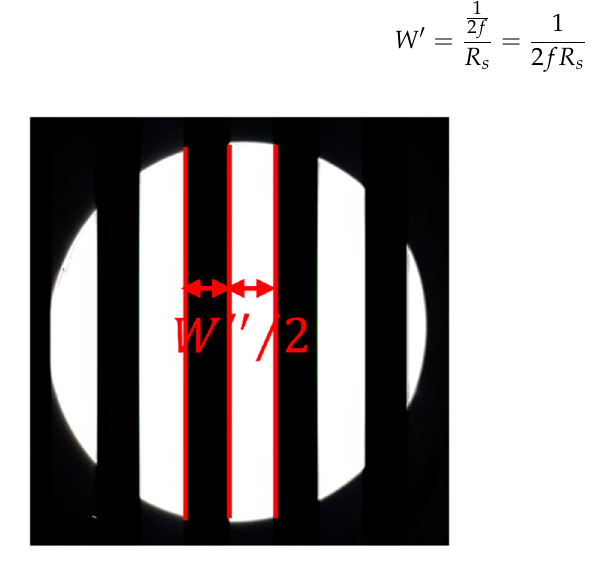
Figure 5. Estimation of strip widths during the decoding process.